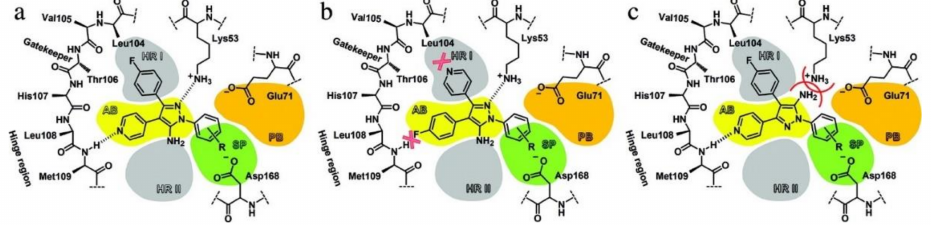
Figure 97. ( a ) Binding interactions of the regioisomer of compound 92 with p38 α . ( b , c ) Effects of regioisomerism on declined activity against p38 α